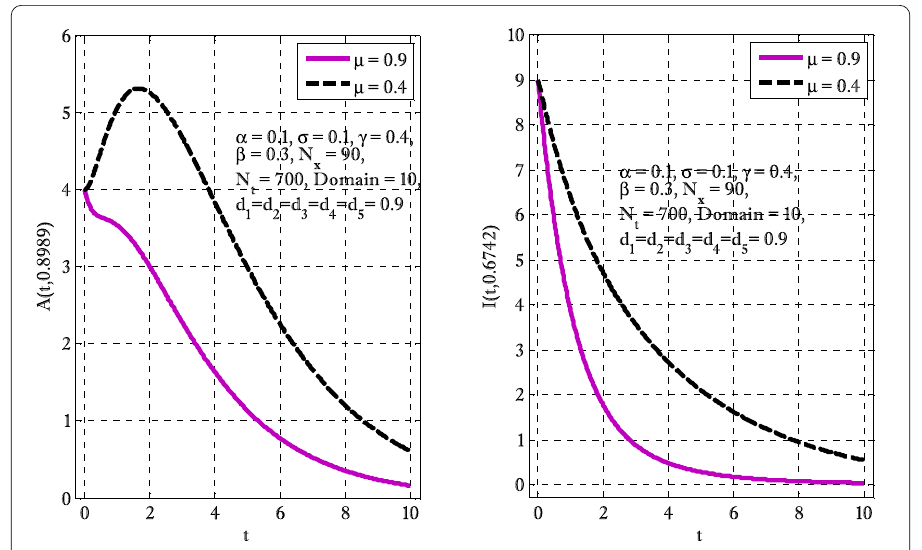
Figure 5 Asymptomatic and infected individuals with the variation of recovery rate parameter μ